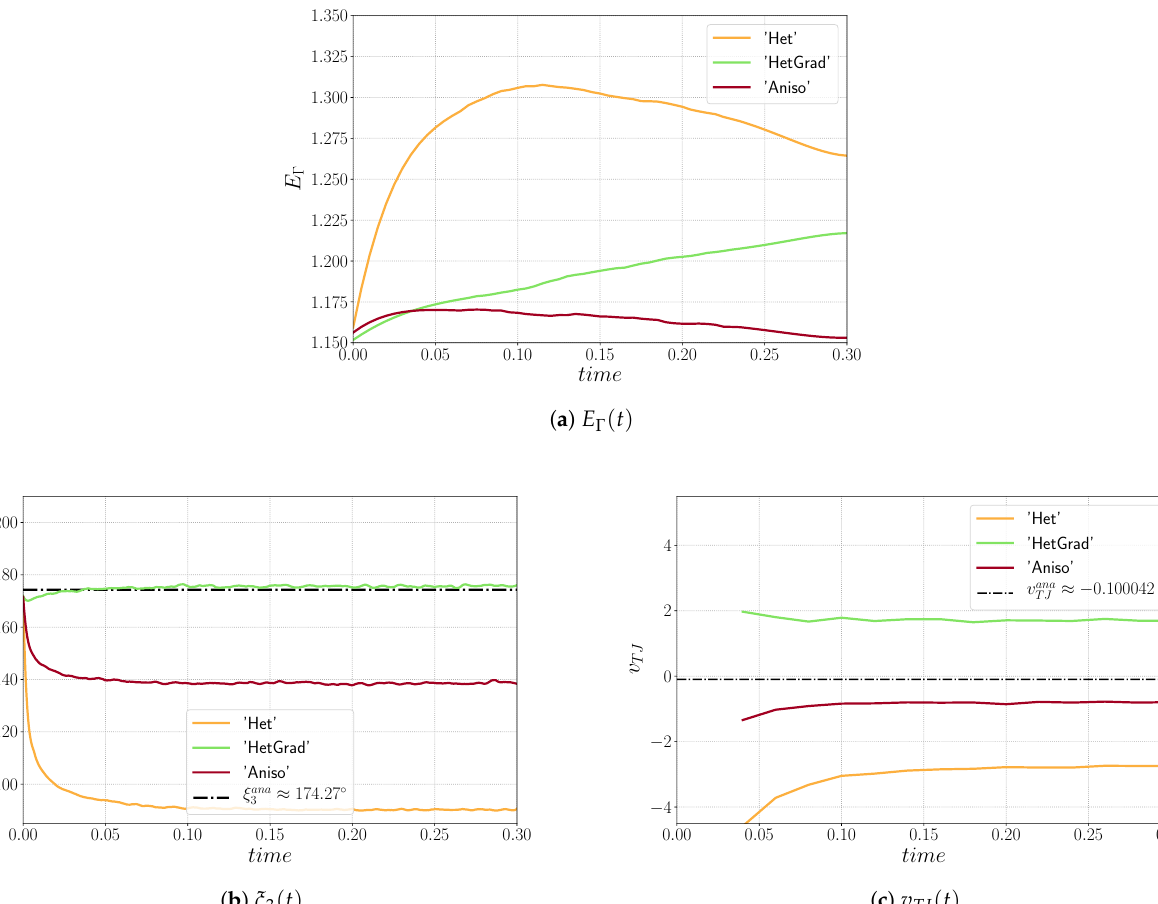
Figure 9. Time series of E Γ , ξ 3 , and v TJ for the three formulations ( r = 10). The level of anisotropy defined here is high ( r = 10), and this order of value has also been discussed in the literature [26,30,51] and remains necessary to discuss realistic polycrystal aggregates (coherent twin energy, for example). In Figure 10, the effect of the anisotropy level ( r value) on the top dihedral angle and the triple junction velocity is illustrated. We have carried out simulations using h = 1 10 − 3 , ∆ t = 1 10 − 4 and × × 0.55, 0.625, 0.714, 0.833, 1.0, 1.25, 1.66, 2.5, 5, 10 , which are equivalent to γ bot r ∈ { } ∈ 1.8, 1.6, 1.4, 1.2, 1.0, 0.8, 0.6, 0.4, 0.2, 0.1 . These results allow us to conclude that { } the Het methodology is not adapted whatever the r value. Interestingly, the HetGrad formulation seems very good for ξ 3 and v TJ for r < 1.5, but the migration direction ends up being reversed for higher r values, while keeping an excellent profile for the equilibrium angles. Finally, if the angle respect is slightly worse for the Aniso formulation, the respect of the triple junction speed is much better as soon as r > 1. In Figure 10b, the three additional dashed lines represent the expected velocity for the ξ 3 values obtained after reaching equilibrium, as illustrated in Figure 10a using Equation (25). One can see that the Het and HetGrad formulations correlate ξ 3 and v TJ for r < 1. On the other hand, the Aniso formulation correlates ξ 3 and v TJ for every r value. A good correlation could be advantageous if one wants to perform more realistic simulations where correct kinetics and topology of the microstructure are of significant importance. An additional analysis is presented in the Appendix A, where a modified Grim Reaper case with Dirichlet boundary conditions is detailed. The obtained results have similar trends to those presented in Figure